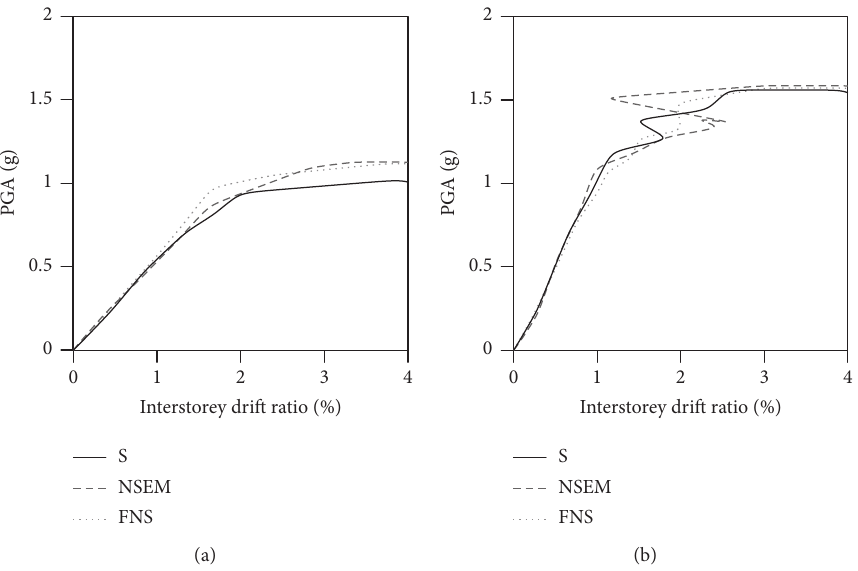
Figure 10: Average IDA curves (PGA vs. maximum interstorey first-floor drift ratio). (a) M1 model. (b) M4